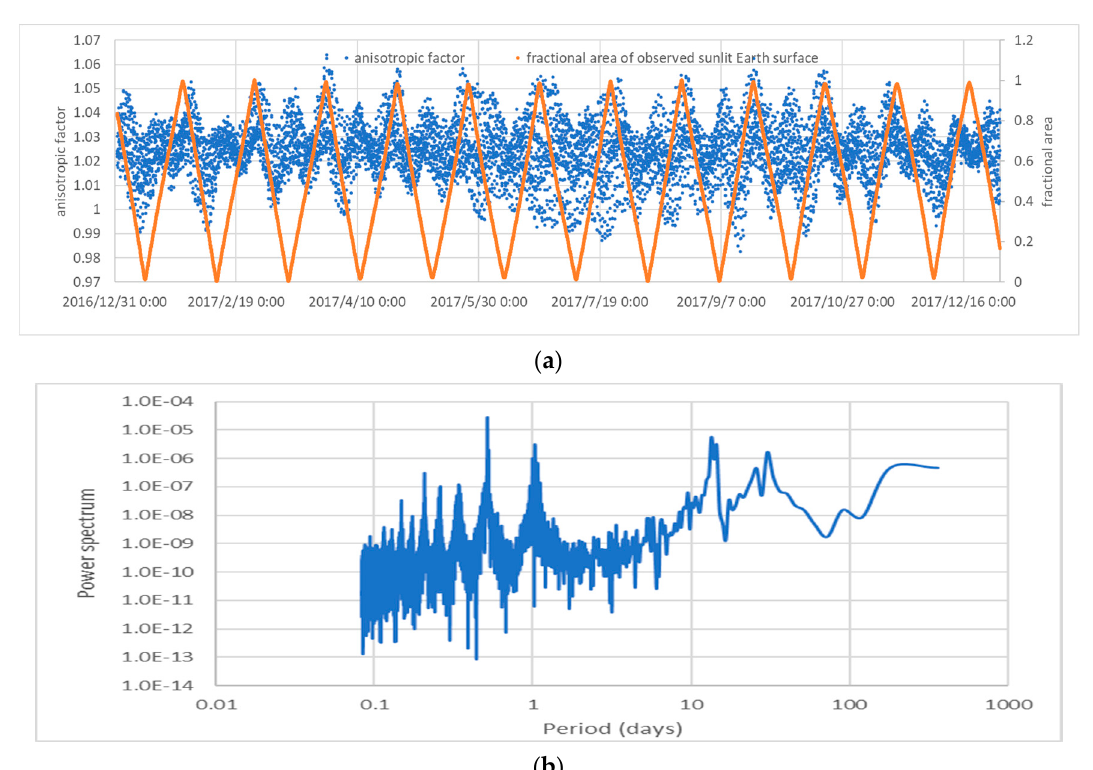
Figure 13. The time series of the global longwave anisotropic factor of Earth TOA in the Moon-based view and the fractional area of the observed sunlit Earth surface in 2017 ( a ) and the power spectrum of the time series of the global longwave anisotropic factor ( b ). The fractional area of the observed sunlit Earth surface was calculated as the ratio of observed sunlit area to the maximum sunlit Earth area.